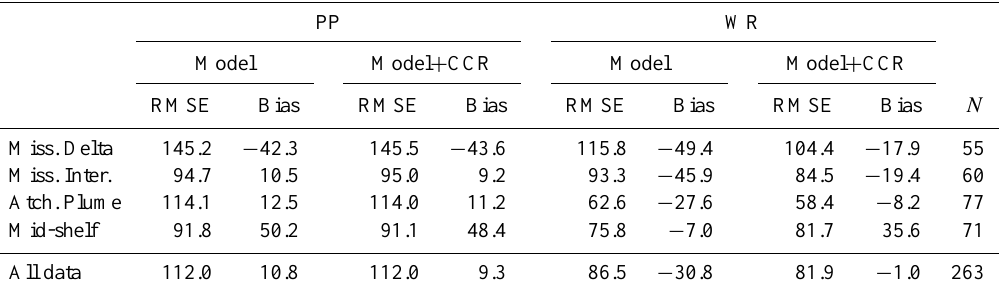
Table 2. RMSE and bias (both in units of mmolO 2 m − 2 d − 1 ) between simulated and observed primary production (PP) or water column respiration (WR). Comparisons were conducted over the simulation period from 2004 to 2007 using all available observations. Bias was calculated as model minus observations. N is the number of observations for each category. PP WR Model Model + CCR Model Model + CCR RMSE Bias RMSE Bias RMSE Bias RMSE Bias N Miss. Delta 145.2